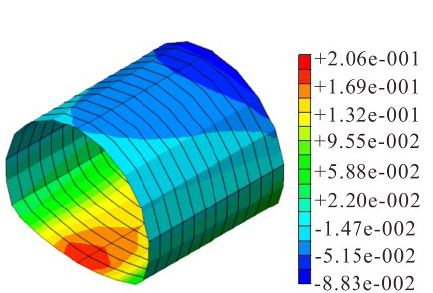
Figure 13. Relation curve of vault settlement with the increase in construction